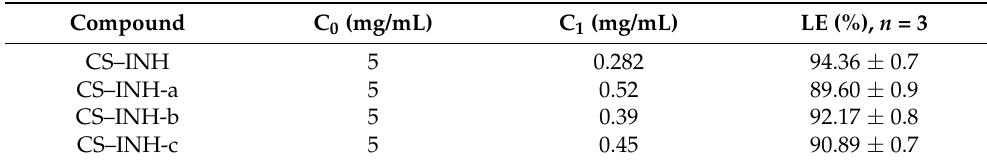
Table 2. Loading efficiency (LE) of chitosan microparticles .